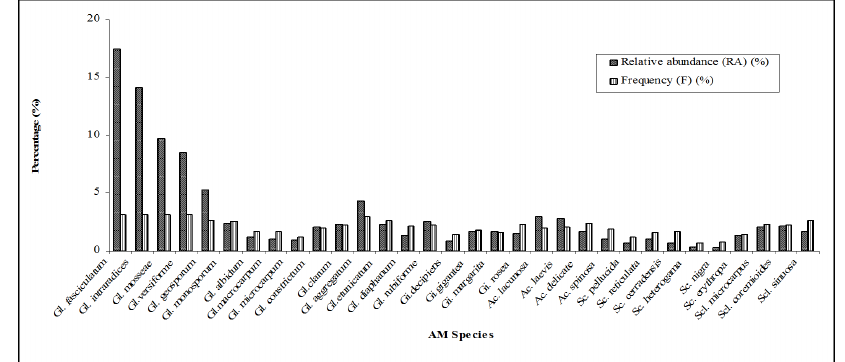
Fig. 3. Relative abundance (RA) (%) and frequency (F) (%) of AM spores identified at species level from the soil samples. Mean values were calculated from the data obtained in all tehsil places belonging to particular district. Note: Gl- Glomus , Gi- Gigaspora , Ac- Acaulospora , Sc- Scutellospora , Sc-